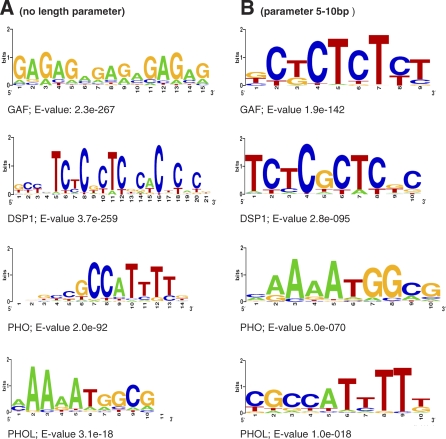
Overrepresented Sequence Motifs of PcG Recruitment Factors in ChIP on Chip Bound Regions Genome Wide(A) Overrepresented DNA motifs of GAF, DSP1, PHO, and PHOL (No motif-length parameter)(B) Overrepresented DNA motifs of DSP1, DSP1, PHO, and PHOL (motif-length parameter 5–10 bp). Sequence logo representation of the consensus is shown for top motif of each profile. MEME E-value for the motif is given below the name of the factor. Note that even though PHO and PHOL regions have the same overrepresented motif, the motif in PHOL is weakly enriched and may be a consequence of the basal PHOL-PHO overlap.